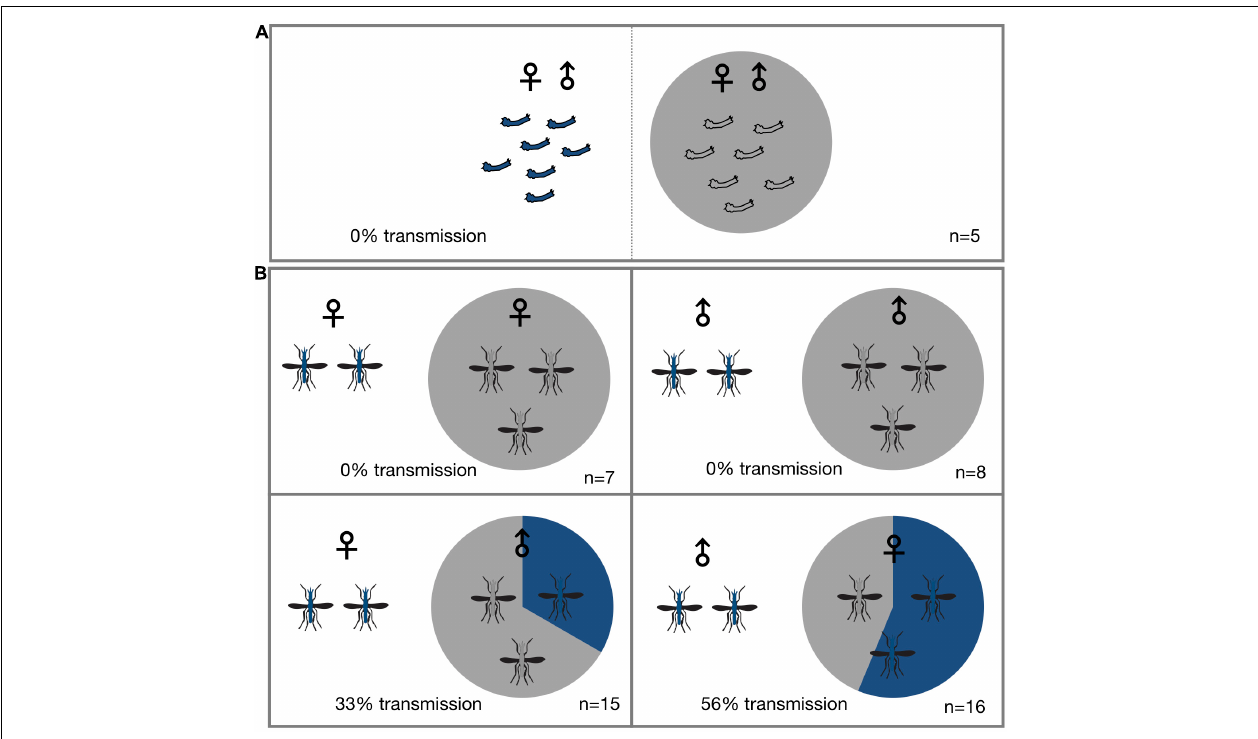
FIGURE 1 | Horizontal transmission of Microsporidia MB. Mosquitoes carrying Microsporidia MB are represented with blue shading in pie charts and n = number of independent experiments. (A) No transmission of Microsporidia MB was observed between An. arabiensis larvae reared in the same larval trough but separated by a screen mesh. (B) Horizontal transmission of Microsporidia MB was observed when adults were kept together in cages, and specifically when either infected males or females were housed with uninfected An. arabiensis of the opposite sex. Top row, no transmission was observed between infected and uninfected individuals of the same sex. Bottom left, transmission between Microsporidia MB infected An. arabiensis females and uninfected males was observed in 5 out of 15 cages (33%). Bottom right, out of a total of 16 experiments that had Microsporidia MB infected males and uninfected females and horizontal transmission was confirmed in 10 of these cages (56%